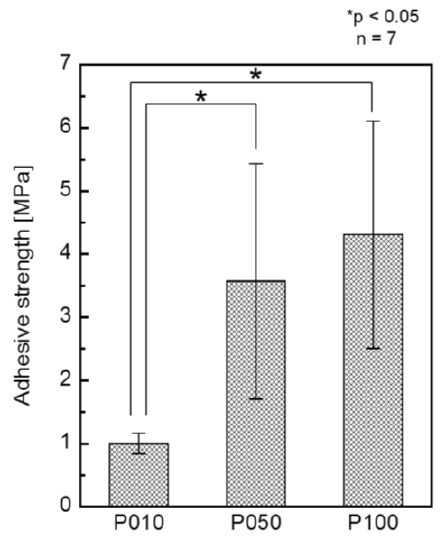
Figure 7. Adhesion strengths of the apatite coatings to the surfaces of the plate specimens P010, P050, and P100 ( n = 7, * p < 0.05).